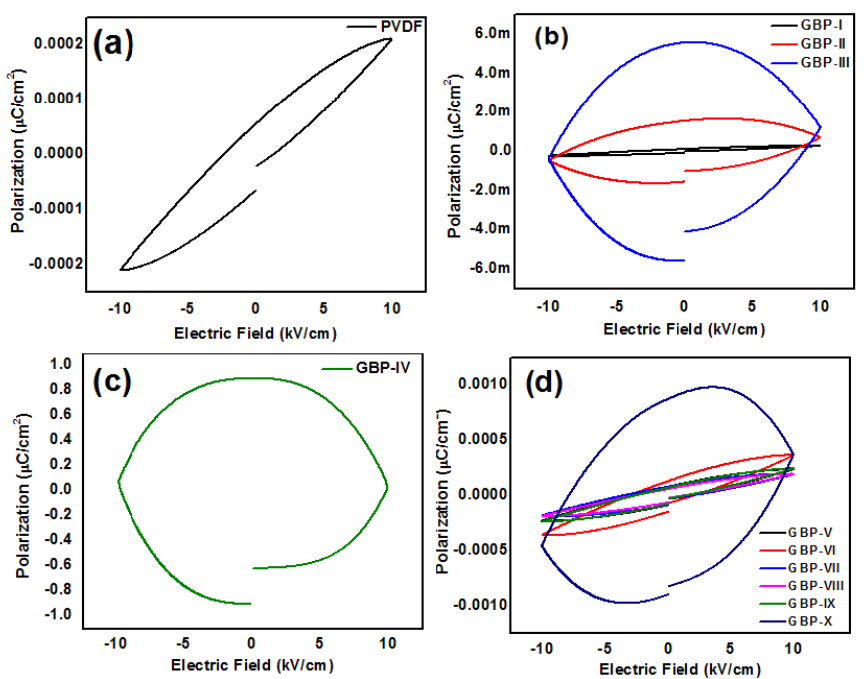
Figure 9. Polarization electric field (P-E) hysteresis loop of ( a ) neat PVDF ( b ) GBP-I, GBP-II, GBP-III ( c ) GBP-IV ( d ) G/BT/PVDF nanocomposite films with different BT fractions.